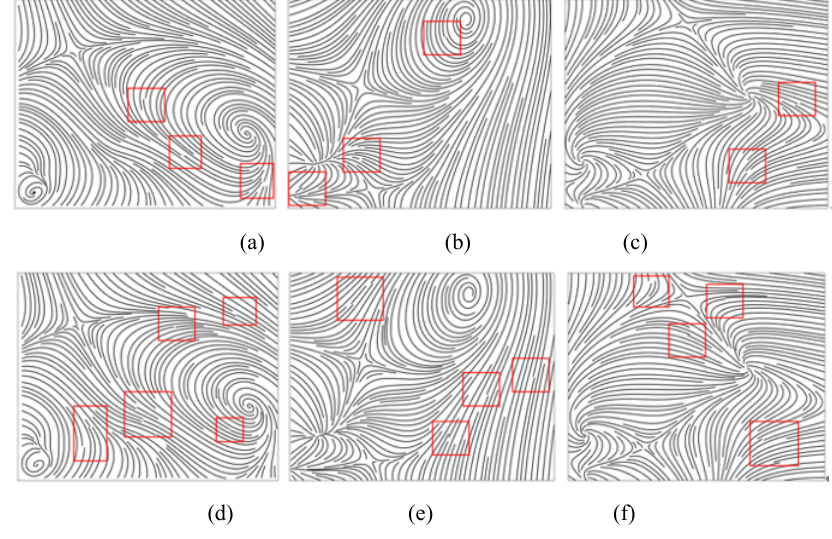
Fig. 5. Comparisons between our algorithm and the Jobard